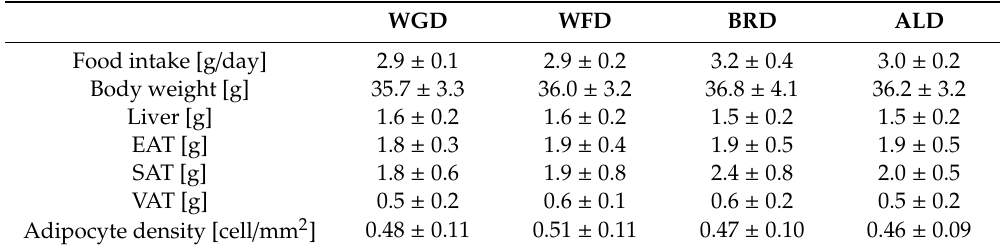
Table 2. Food intake as well as phenotypic data of C57BL/6J mice fed one of four high-fat diets (HFDs) for 12 weeks.